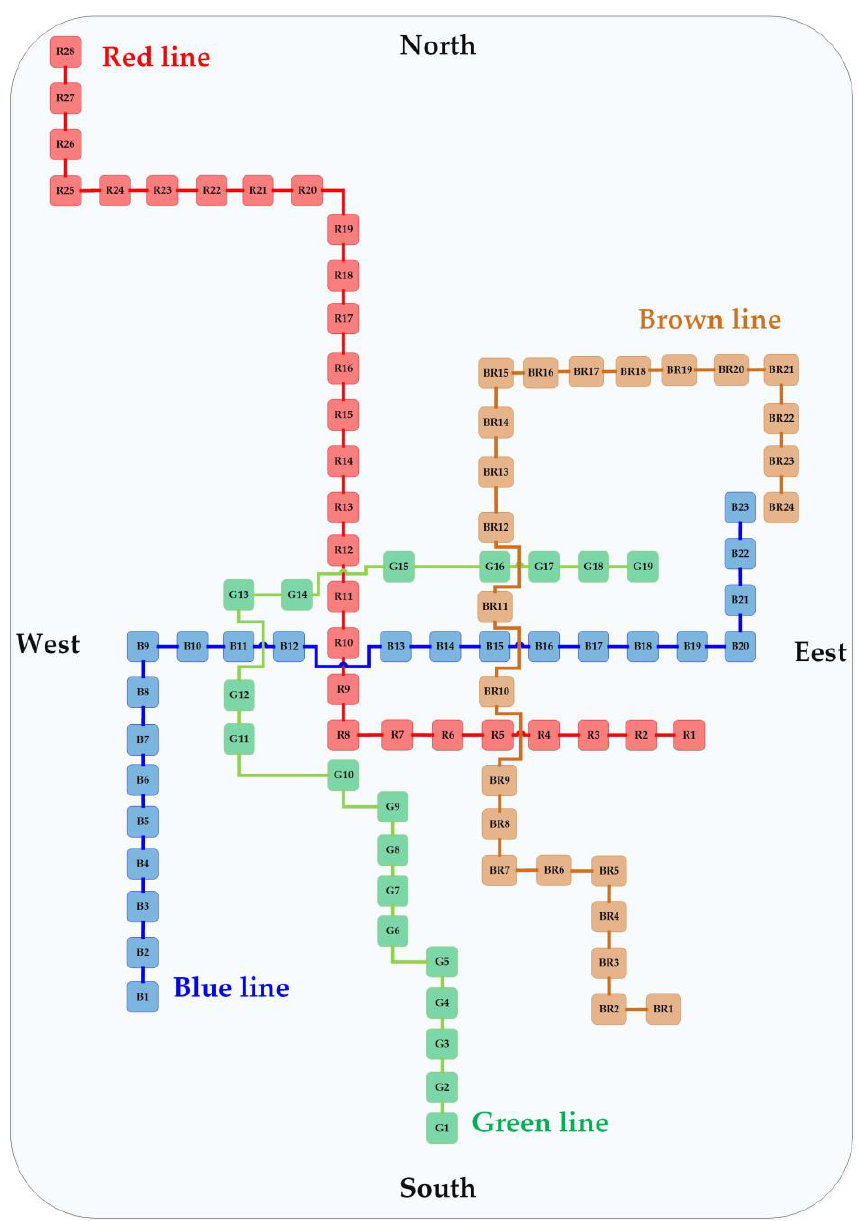
Figure 3. Schematic diagram of four metro lines of the Taipei Rapid Transit Corporation.